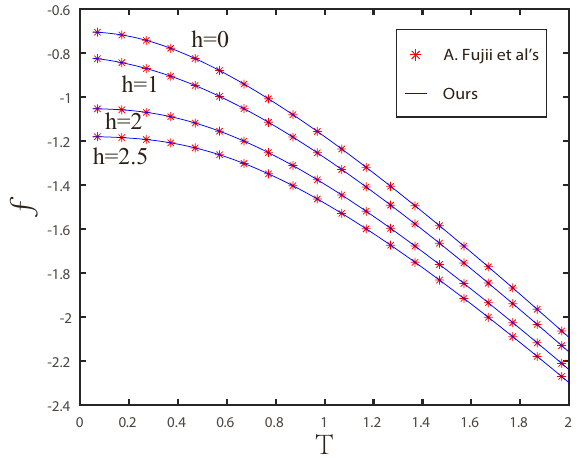
Figure 5 . Free energy f vs T for the periodic SU(3) chain in different magnetic